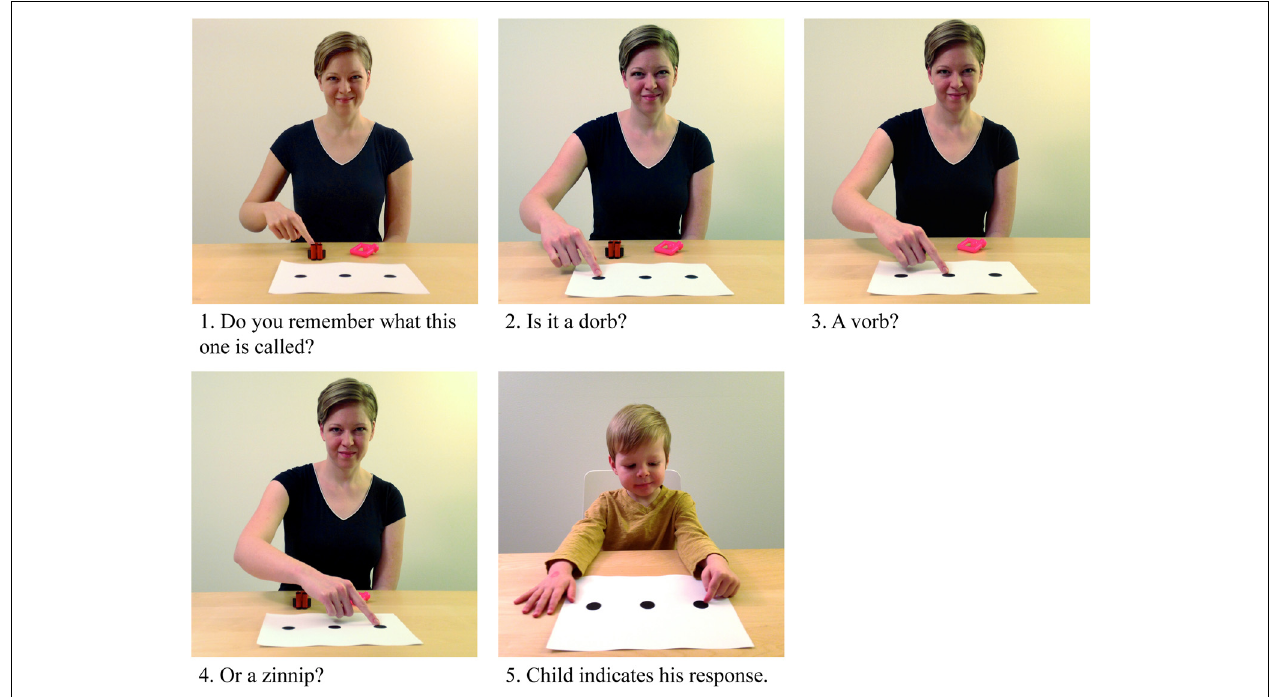
FIGURE 1 | Procedure used for the three alternative forced choice form